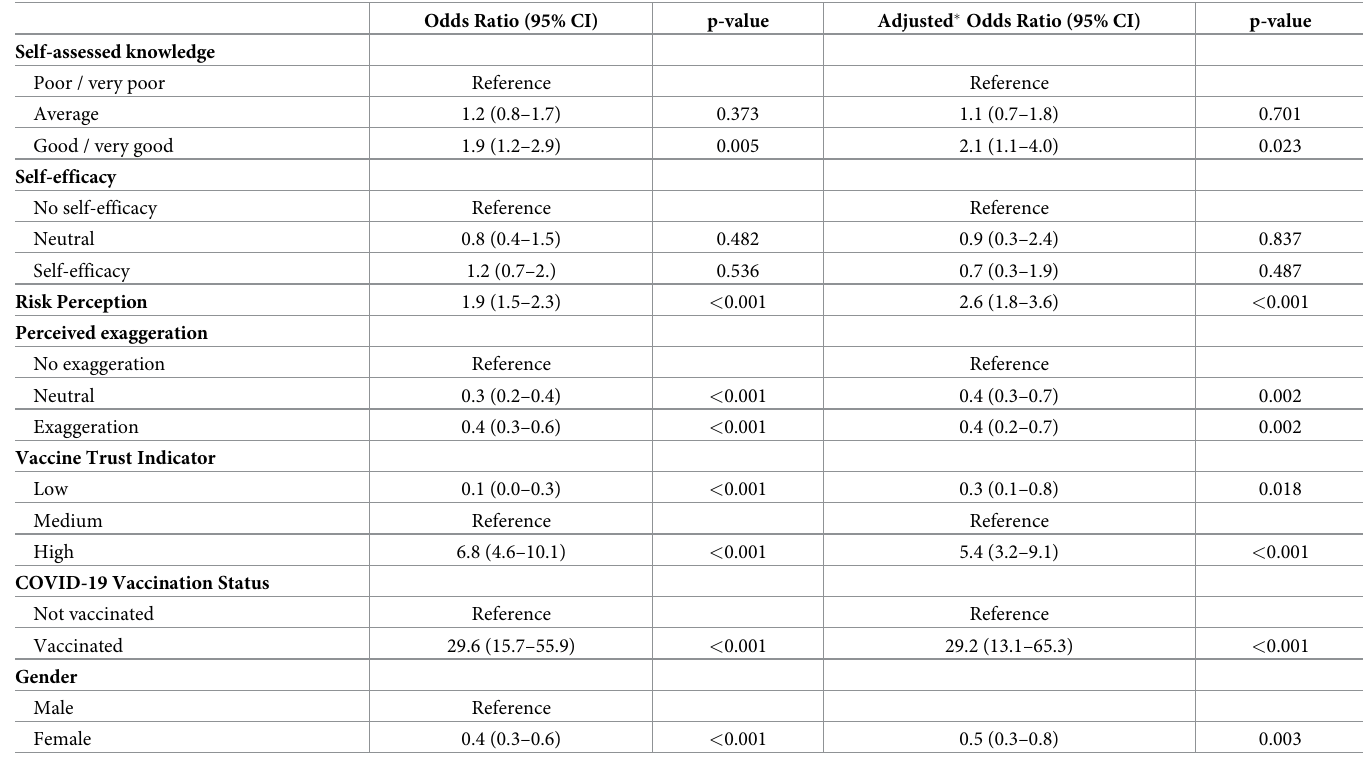
Table 4. Associations with intentions to receive a Monkeypox vaccine, if